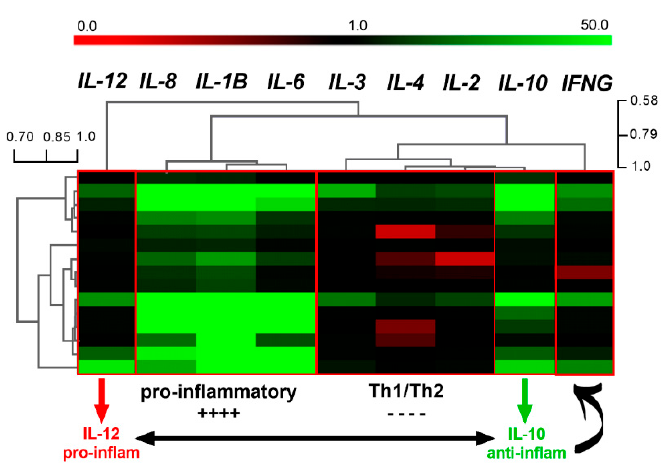
Figure 1. Hierarchical cluster tree of cytokine gene expression data generated from chicken peripheral blood mononuclear cells (PBMC) stimulated with TLR agonists. The cytokine gene panel included: IL-1 , IL-2 , IL-3 , IL-4 , IL-6 , IL-8 , IL-10 , IL-12p40 , and IFN- ɣ genes . Gene expression analy- sis performed using RT-qPCR with ACTB and G6PDH reference genes. Hierarchical Cluster Tree constructed in the Multiexperiment Viewer (MeV) version 4.9.